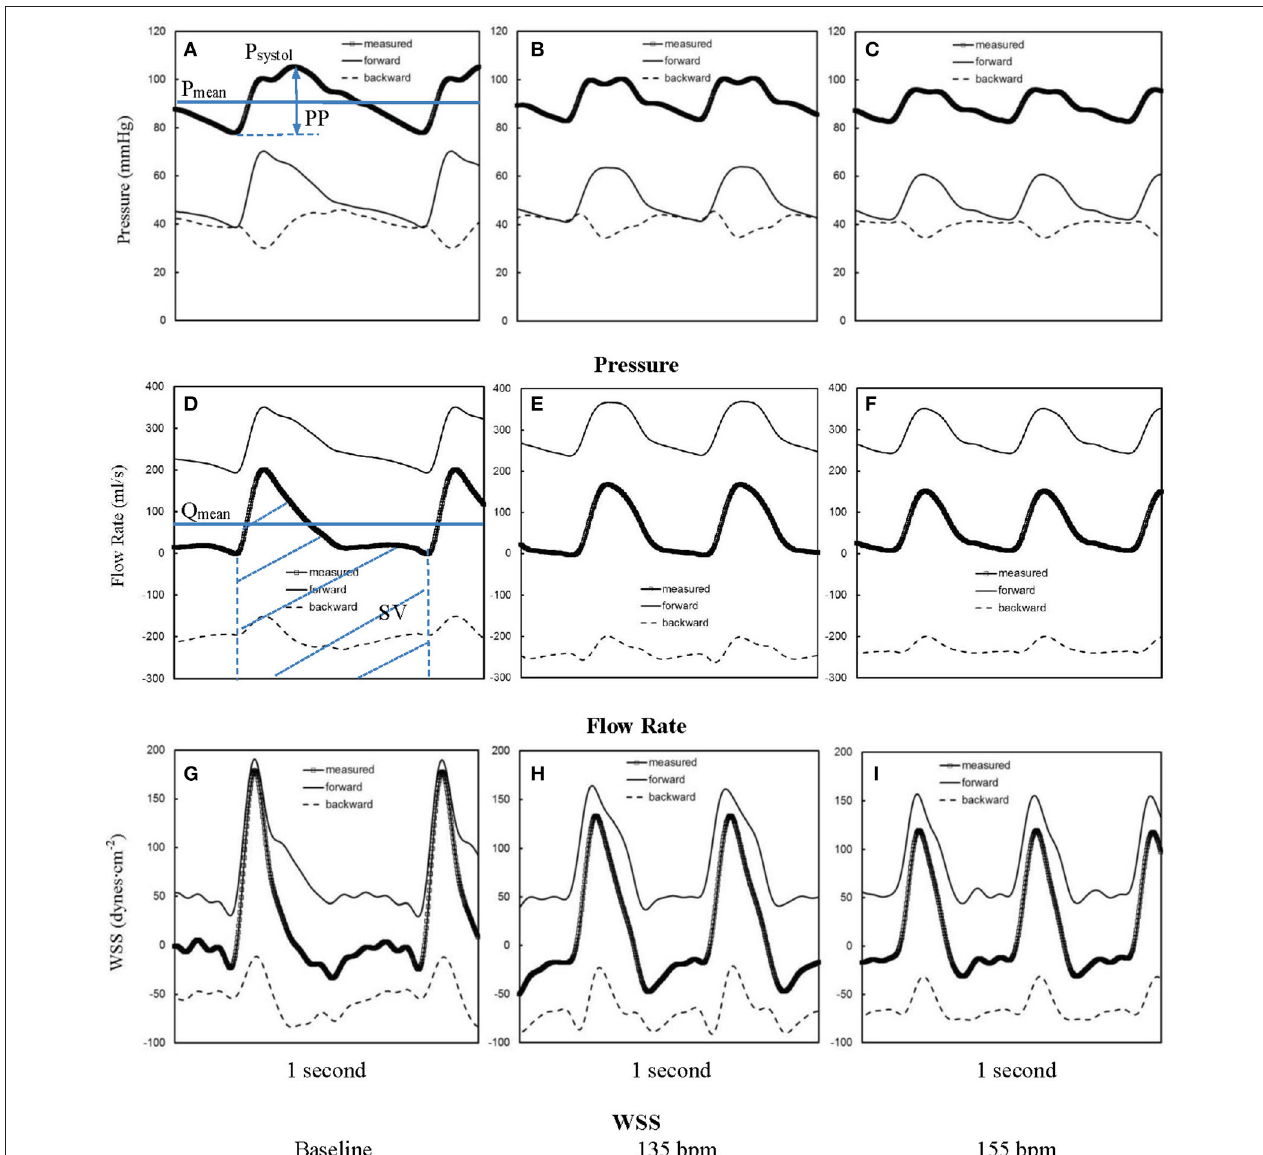
FIGURE 1 | Pressure waves in ascending aorta (A) at baseline and after the heart rate was paced to (B) 135 bpm and (C) 155 bpm. (D–F,G–I) refer to flow and WSS waves, respectively, in ascending aorta corresponding to A–C . The marked, solid, and dash lines represent the measured, forward, and backward waves, respectively.